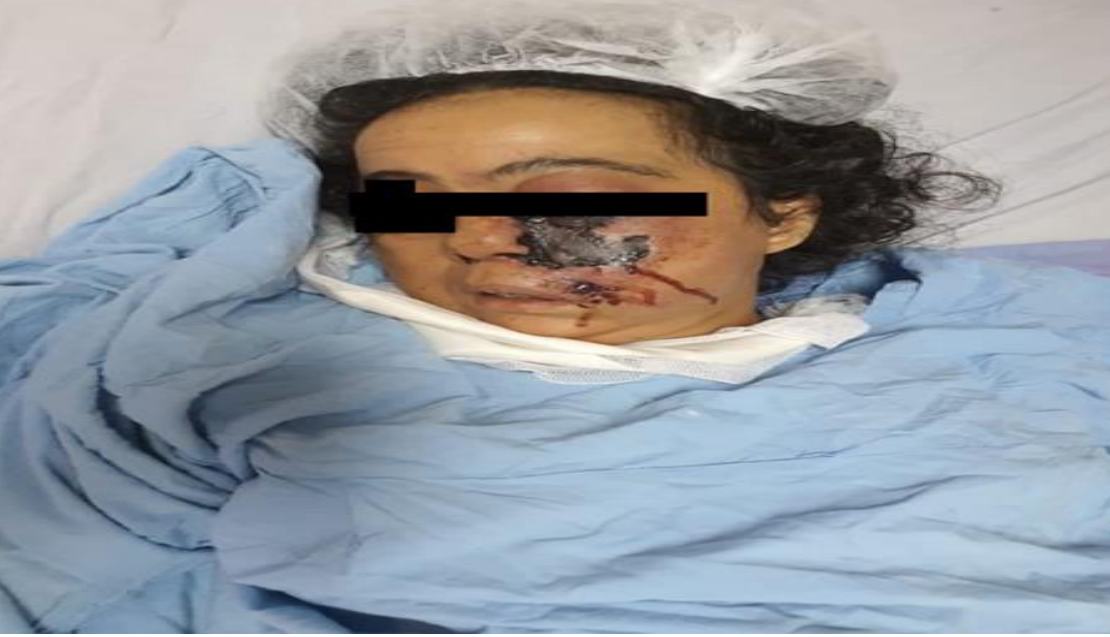
Figure 4. Cutaneous Mucormycosis involving the face in the form of necrotic black eschar and left eye